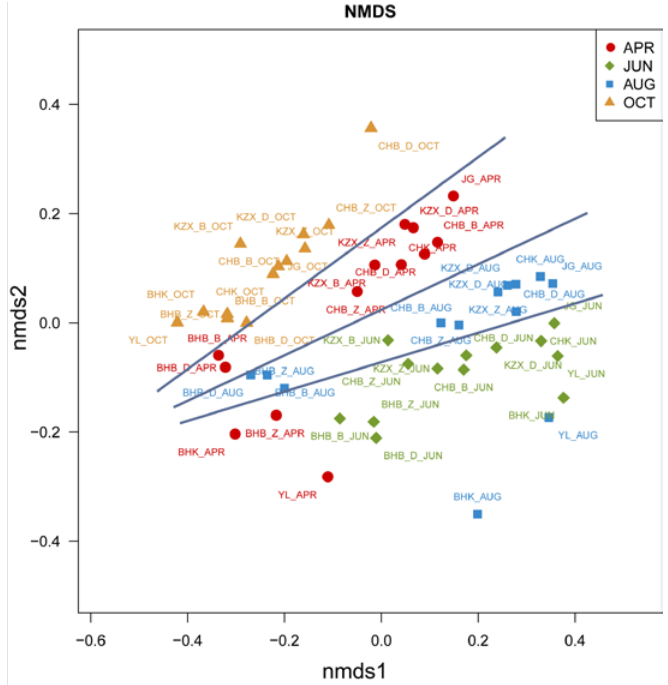
Figure 3. Non-metric multidimensional (NMDS) scaling plot distances used to estimate the temporal and spatial dynamics of the community structure.